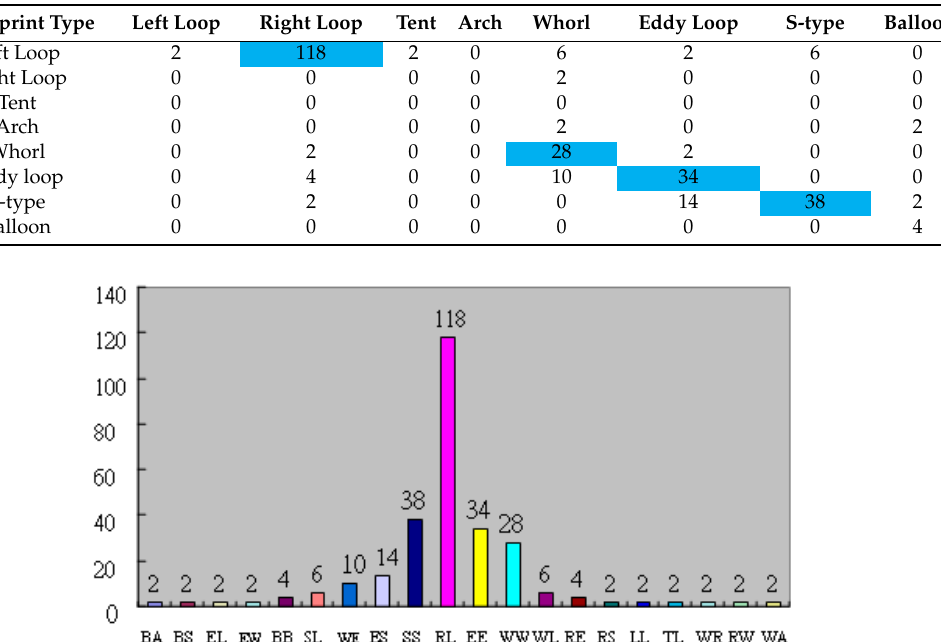
Figure 3. Fingerprint type statistics. BA: Balloon/Arch; BS: Balloon/S-type; EL: Eddy Loop/Left Loop; EW: Eddy Loop/Whorl; BB: Balloon/Balloon; SL: S-type/Left Loop; WE: Whorl/Eddy Loop; ES: Eddy